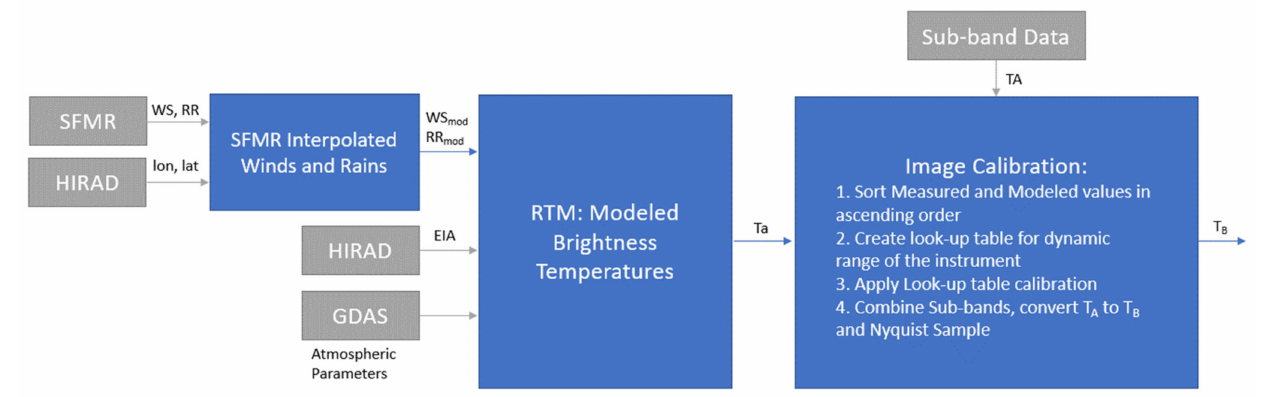
Figure 5. HIRAD T A calibration block diagram, where boxes in grey are data inputs and boxes in blue are the data processing